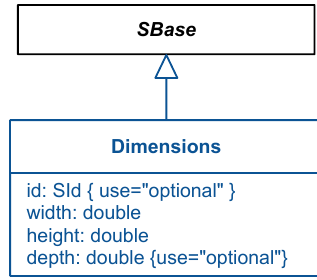
Figure 3: The definitions of the Dimensions